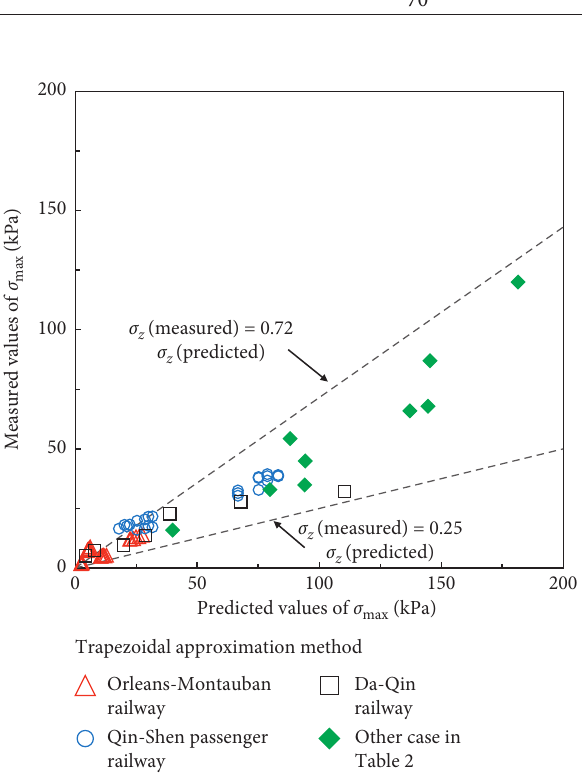
Figure 4: Comparisons between predicted results in the trape- zoidal method and measured vertical stresses.